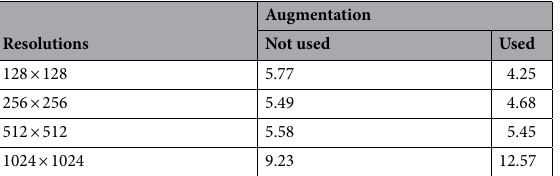
Table 5. SWD values of each resolution with and without data augmentation. A small value of SWD indicates that the true images and generated images seem to be similar in both appearance and variation.